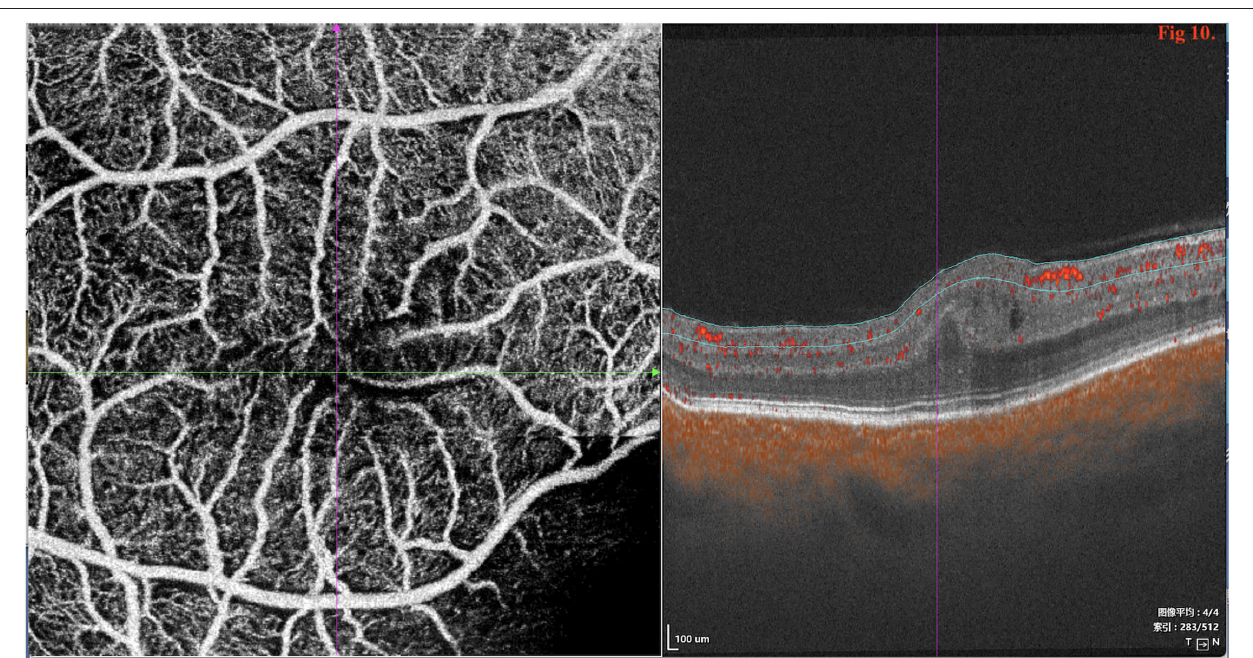
FIGURE 10 | SD/SS-OCTA (SS-OCT, VG200D, SVision Imaging, Ltd., China) in type 1 revealed that the macular morphology was crowded and showed macular dysplasia with decreased size of foveal avascular zone (FAZ).